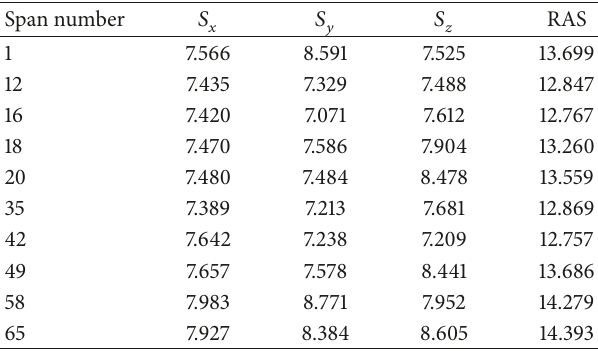
Table 3: The resultant average spectrum (RAS) of the concrete lin-